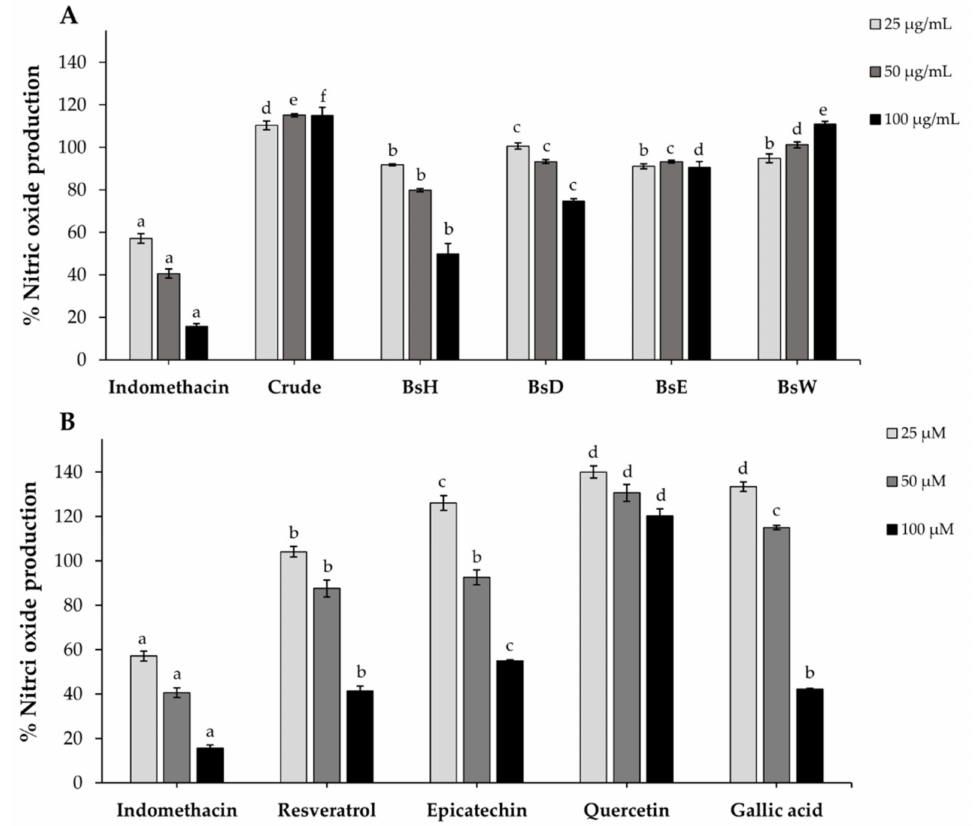
Figure 5. The percentage of nitric oxide production in LPS-induced Raw264.7 macrophage cells after 24 h of incubation with crude extract ( A ), partitioned fractions ( A ), and isolated compounds ( B ). Indomethacin was used as a positive control. Data are expressed as mean ± SD ( n = 3). Different letters indicate a lack of significant difference ( p <